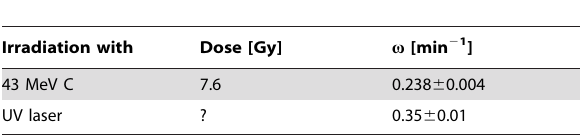
Table 5. 53BP1 kinetics after ion irradiation compared to UV laser